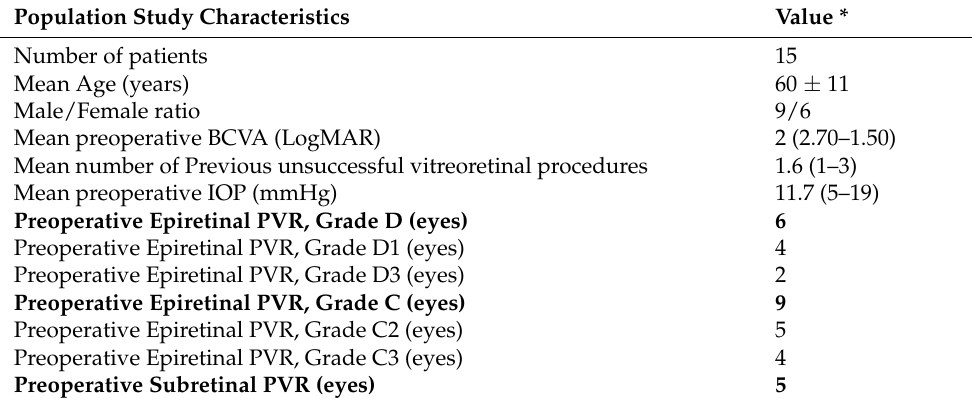
Table 1. Study population and preoperative